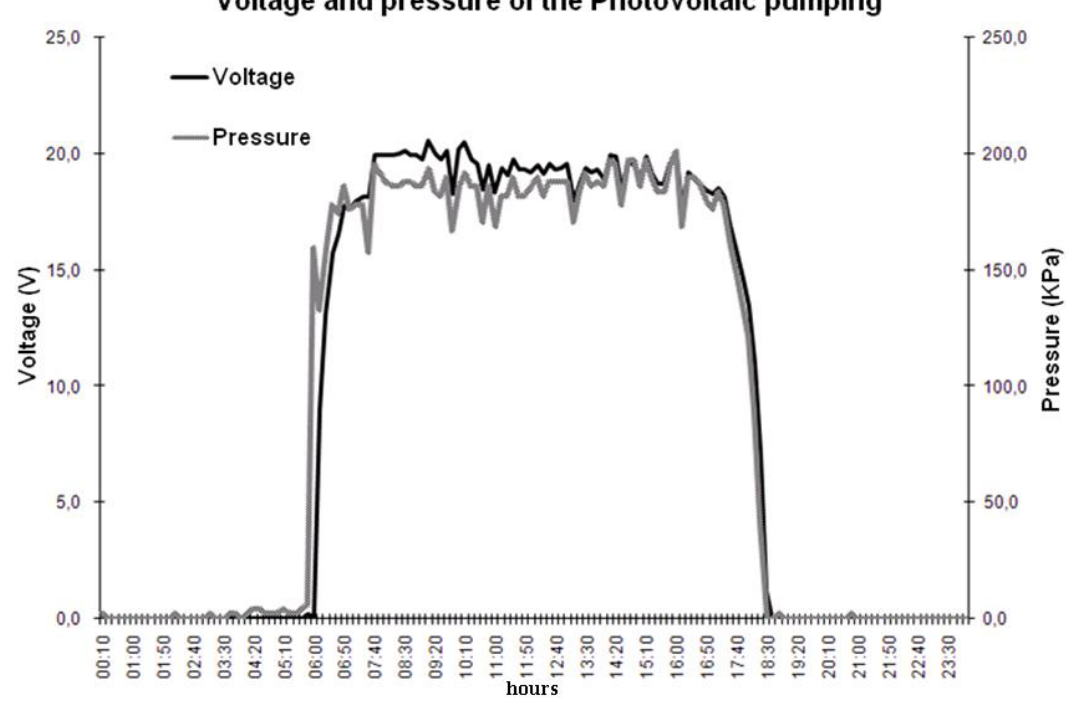
Figure 8. Voltage and pressure graph of a PV powered dc